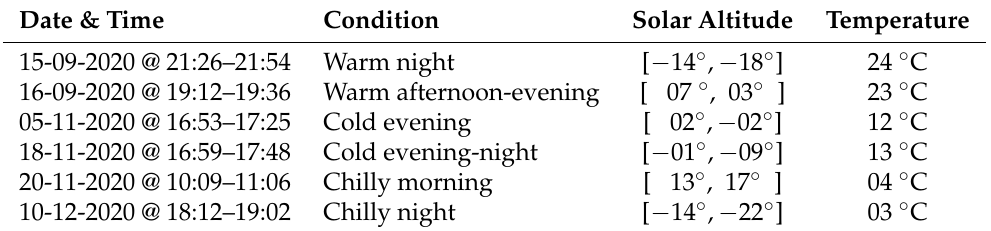
Table 1. Recording scenario for